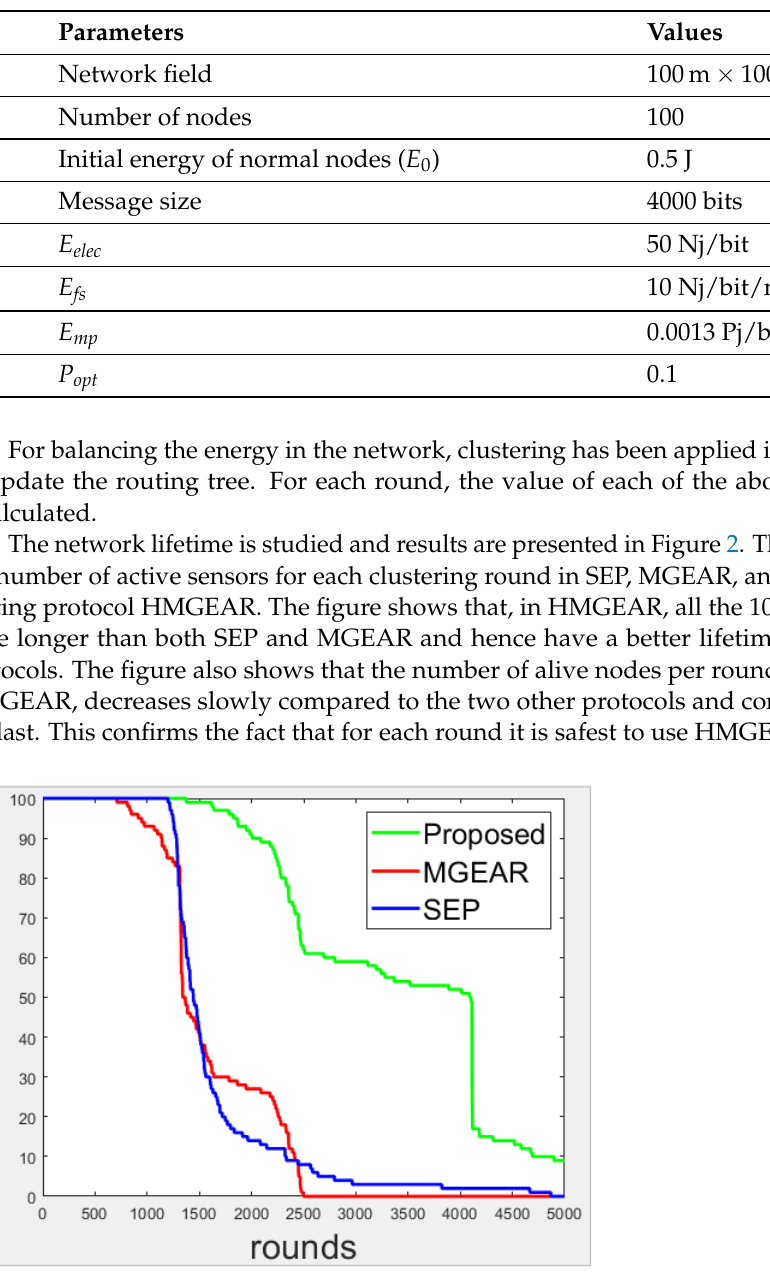
Table 1. Simulation parameters.